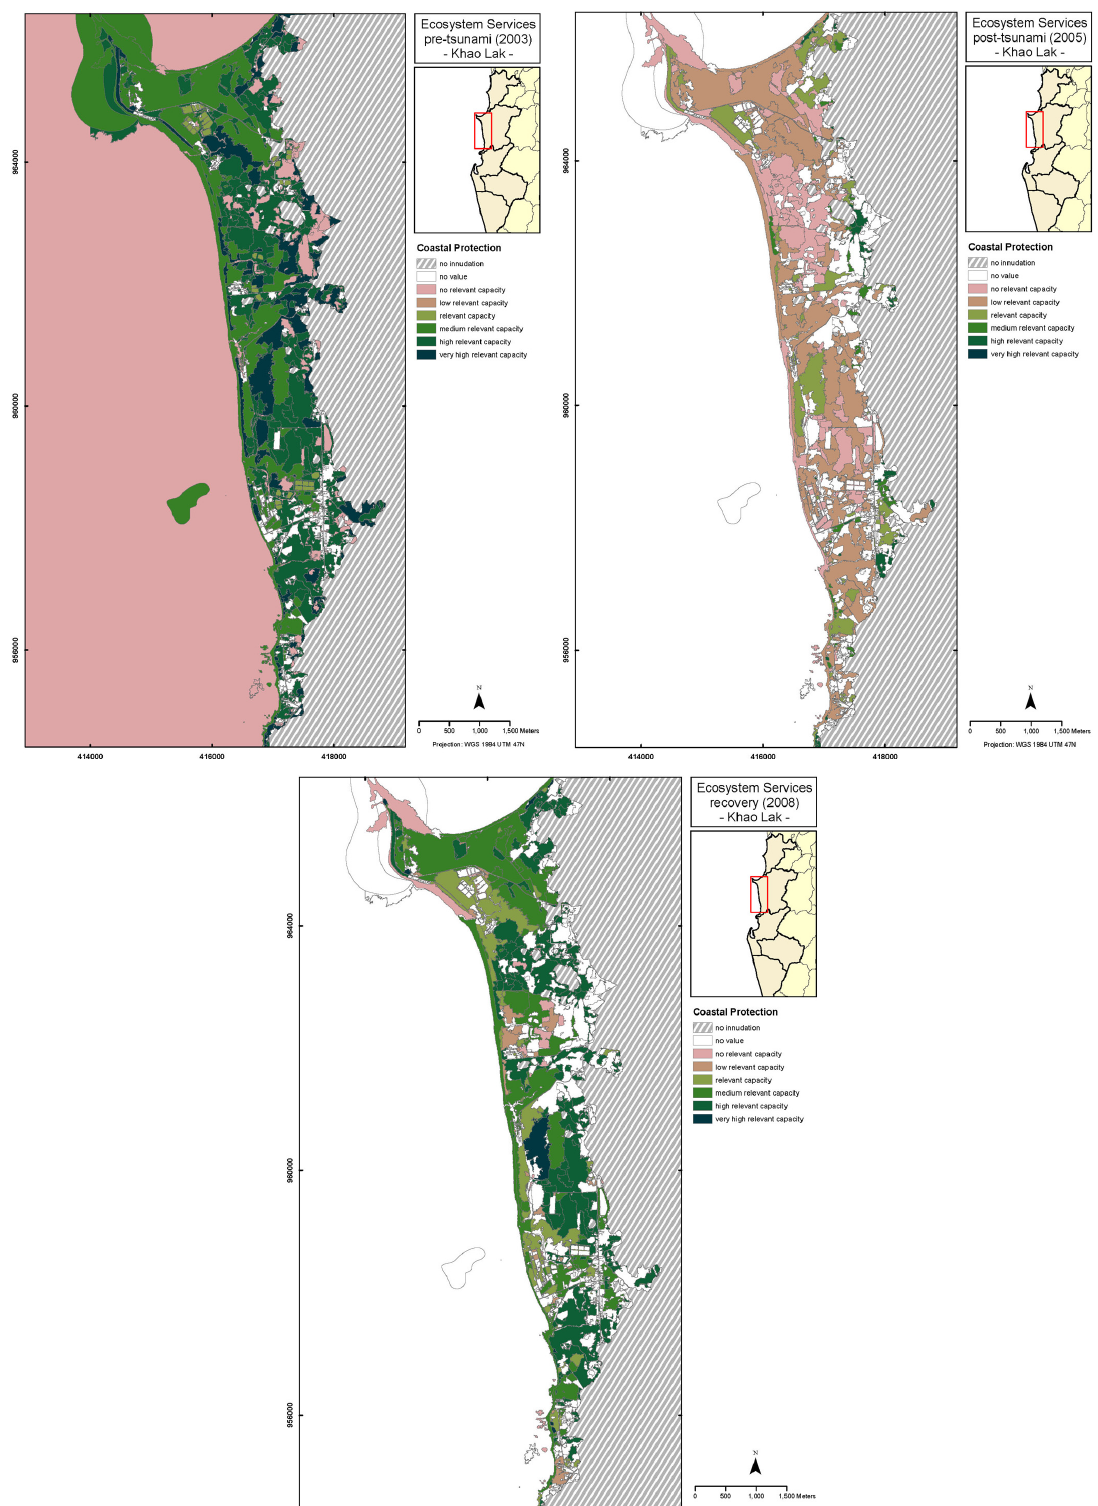
Fig. 6. Map showing the spatial distribution of the ecosystem service “coastal protection” for Khao Lak before the tsunami 2003 (upper panel, left), after the tsunami (01/2005, upper panel, right), and after a recovery time (02/2008, lower panel). White areas represent areas not included in the analysis or no data available on damages or recovery of LULC classes (e.g. ocean, coral reefs, and sea-grass,